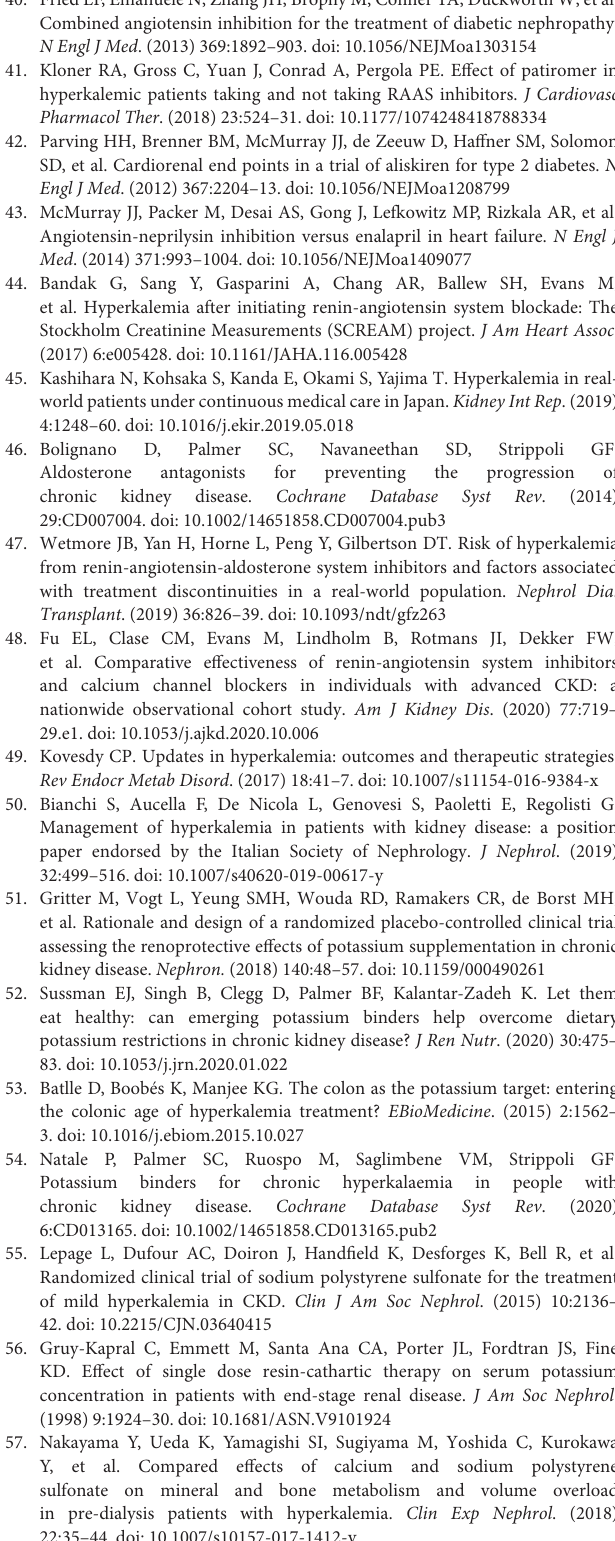
6. doi: 10.1002/ejhf.300 75. Packham DK, Rasmussen HS, Lavin PT, El-Shahawy MA, Roger SD, Block G, et al. Sodium zirconium cyclosilicate in hyperkalemia. N Engl J Med . (2015) 372:222–31. doi: